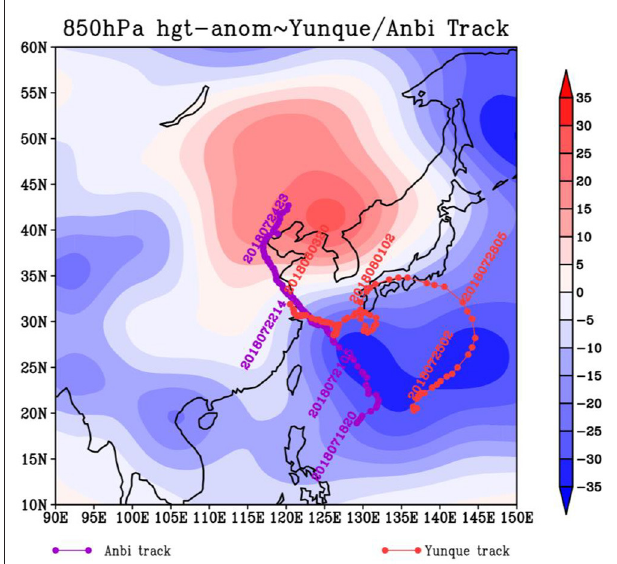
FIGURE 6 | Tracks of typhoons Ampil and Jongdari. The shaded areas are the 850 hPa geopotential height anomalies averaged from July 18th to August 5th in 2018 (gpm).